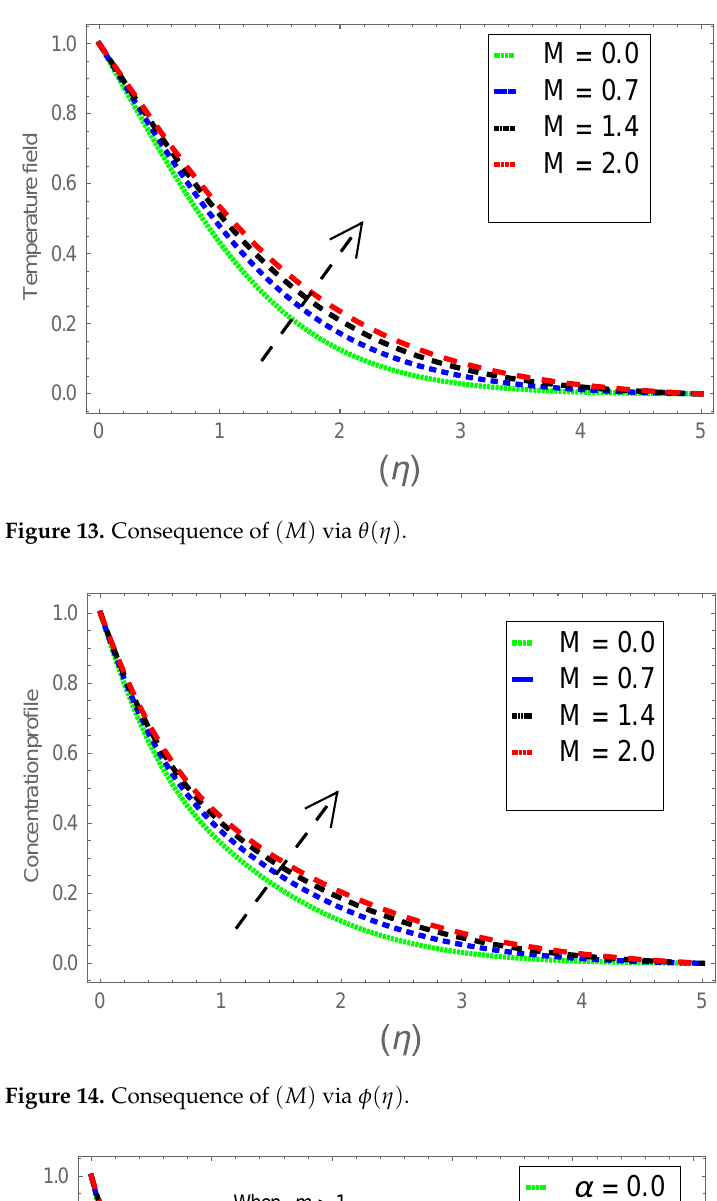
Coatings 2021 , 11 , x FOR PEER REVIEW 16 of 27  Figure 14. Consequence of ( M ) via φ ( η ) .  Figure 14. Consequence of Figure 14. Consequence of